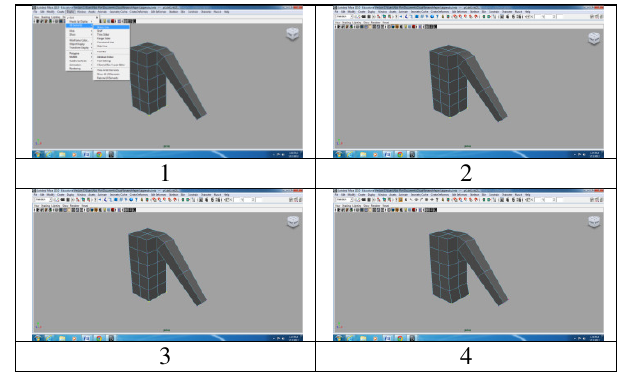
Figure 15. Move Relative operation